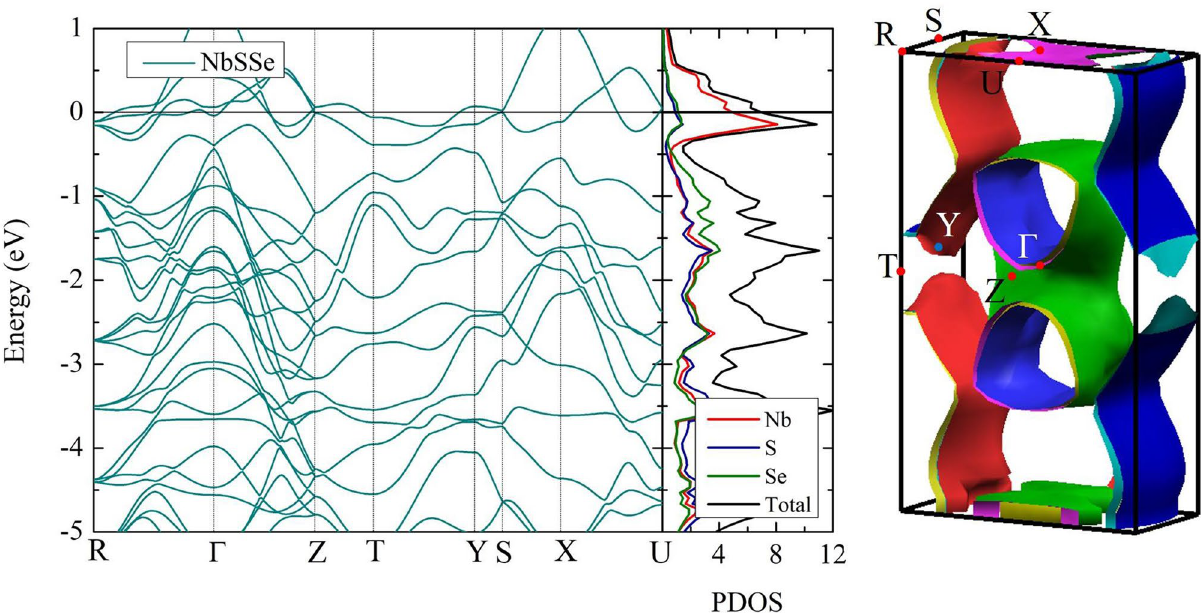
Figure 2. The electronic properties of structure of Nb(Se 0.5 S 0.5 ) 2 (left-hand) the band and DOS, where the red line represents the DOS of Nb atom, the blue line represents the DOS S atom, the green line represents the DOS of Se atom, and the black line represents the total DOS. (right-hand) The FS of the Nb(Se 0.5 S 0.5 ) 2 structure, respectively [drawn by XCrySDen program (ver. 1.5.60) 46 (URL http:// www. xcrys den. org/ Downl oad. html#_ toc_1)].